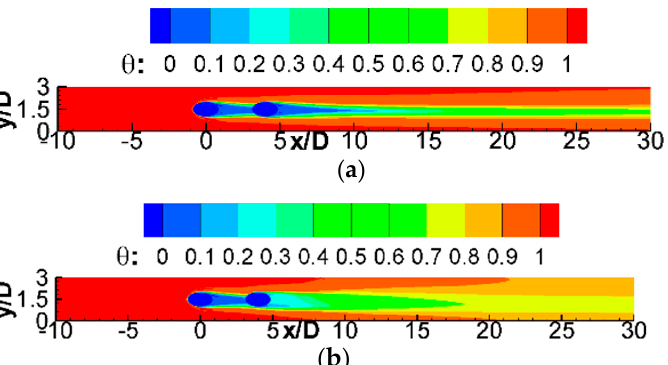
Figure 8. Time-averaged non-dimensional temperature on the bottom wall of ( a ) Case 1 and ( b ) Case 2.